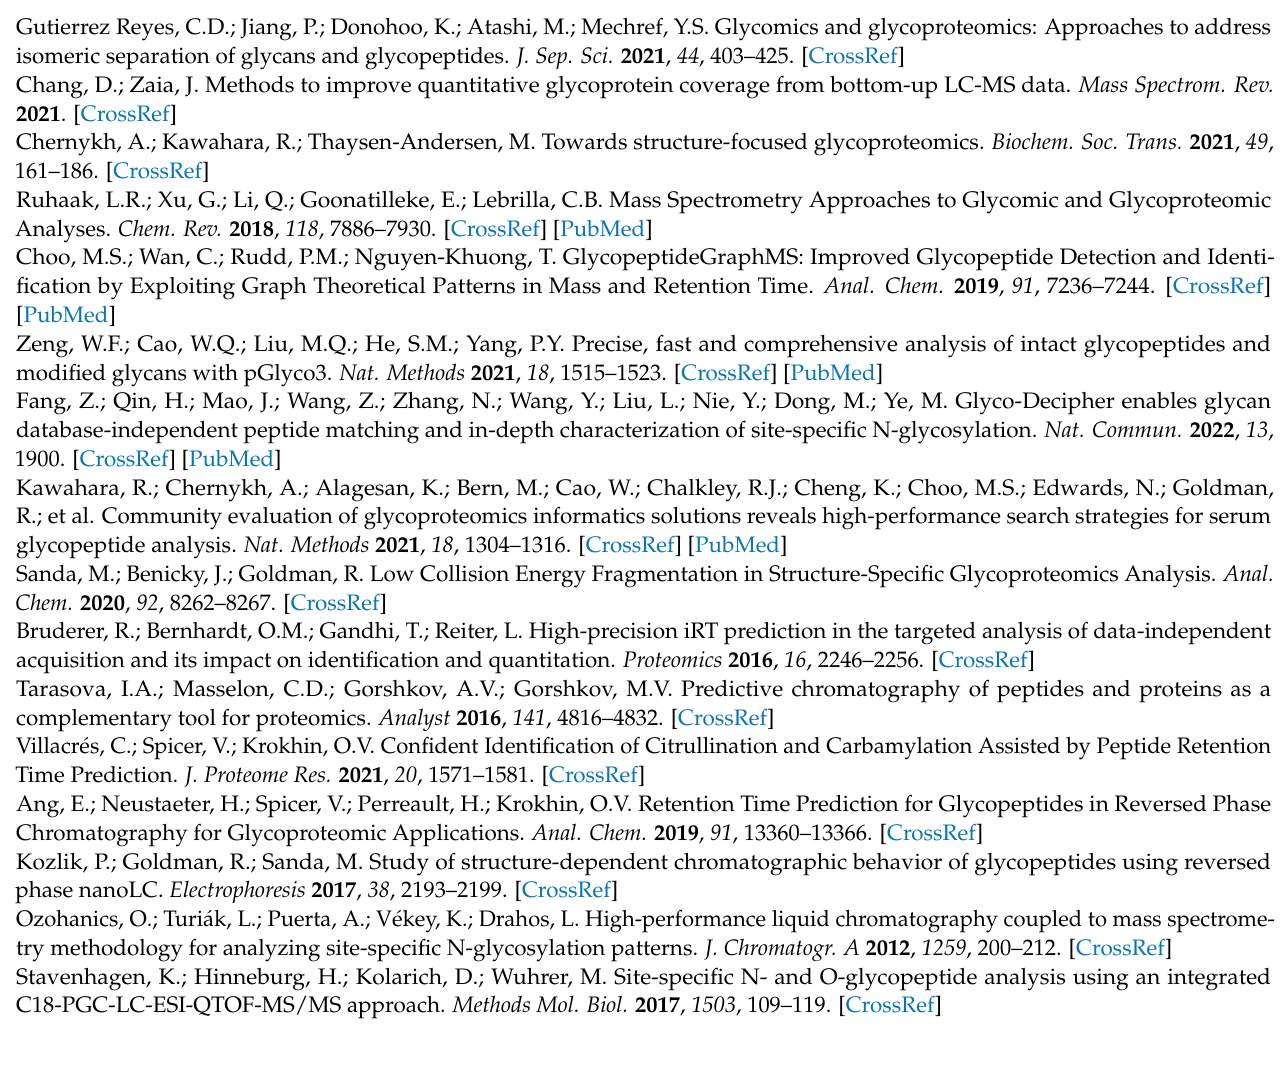
retention times. Figure S3: SRM chromatograms of sex-hormone binding globulin glycopeptides with their relative retention